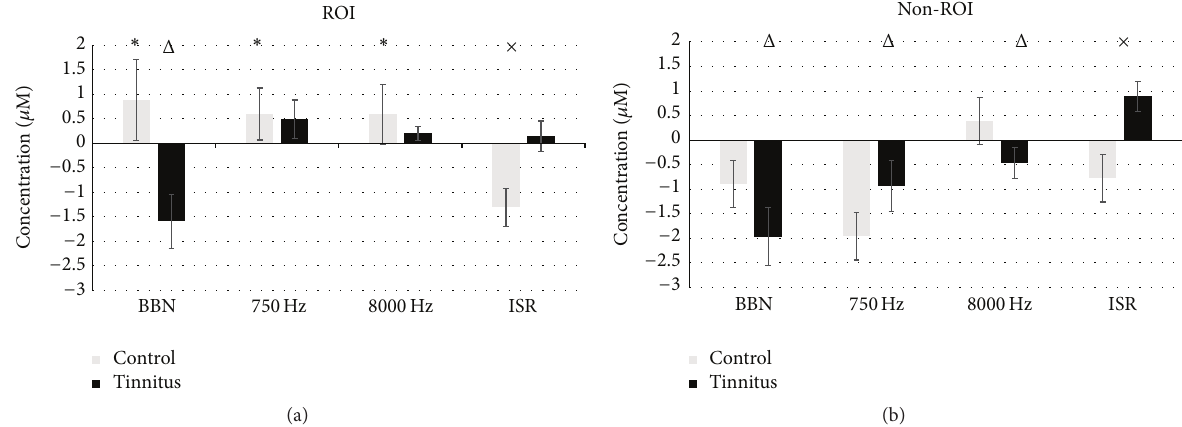
Figure 6: Bar graph of quantified oxy-hemoglobin (HbO) concentration with standard errors in region of interest (ROI; (a)) and nonregion of interest (non-ROI; (b)) under conditions of silence (interstimulus rest; ISR) and stimulation (750Hz, 8000 Hz, and broadband noise; BBN) between tinnitus (dark bars) and control (gray bars). The unit of concentration is micromolar ( 𝜇 M). Standard errors of the mean were calculated using the equation: 𝜎 𝑥 = 𝑆/ √ 𝑁 with 𝑆 = sample standard deviation; 𝑁 = the number of values. Note the maintenance of HbO concentration in ROI (a) and the significant increase in non-ROI (b) during ISR in the tinnitus group as compared to control ( × 𝑝 < 0.05 relative to tinnitus versus controls). Under conditions of stimulation, only BBN suppressed previously maintained HbO levels in tinnitus ROI (a), while all forms of auditory stimulation suppressed increased HbO during ISR in non-ROI ( Δ 𝑝 < 0.05 relative to ISR in tinnitus). Under conditions of stimulation or rest, only the ROI (a) showed a difference between ISR and all forms of auditory stimulation ( ∗ 𝑝 < 0.05 relative to control ISR) and only during ISR significant differences were found between tinnitus and control; × 𝑝 < 0.05 . Error bars represent average responses from 4–18 seconds recorded from all conditions across all